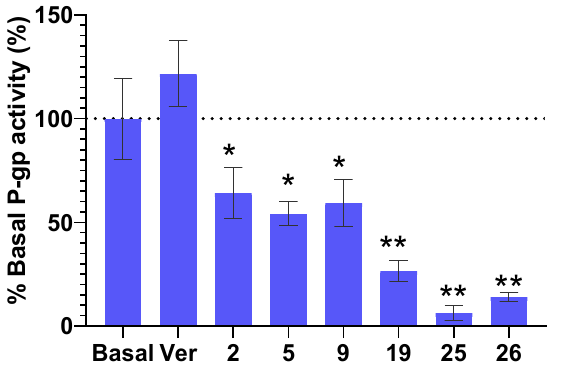
Figure 2. Effect of verapamil and compounds 2 , 5 . 9 , 19 , 25 , and 26 on P-gp ATPase activity. Compounds were tested at 25 µM and verapamil at 0.5 mM. Compounds were identified as P-gp inhibitors if they inhibited the basal activity (<100%) or as substrates if they stimulate the basal activity (>100%). Results were calculated as mean ± SD of at least three measurements. Statistical significance was evaluated by unpaired Student’s t -test (* p < 0.05, ** p < 0.01 compared to the basal